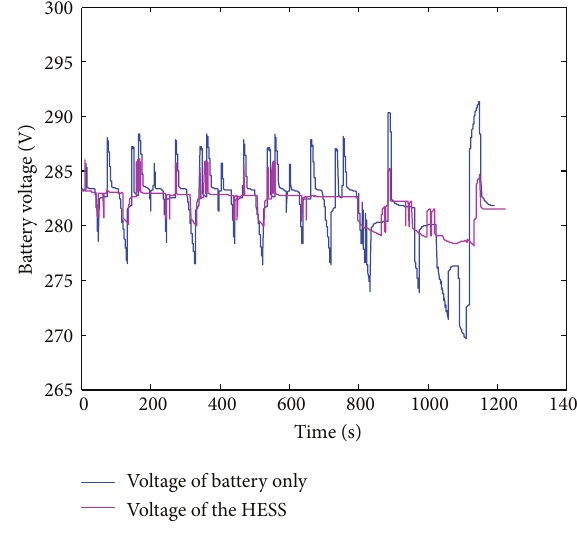
Figure 24: Comparison of the battery voltage curves.